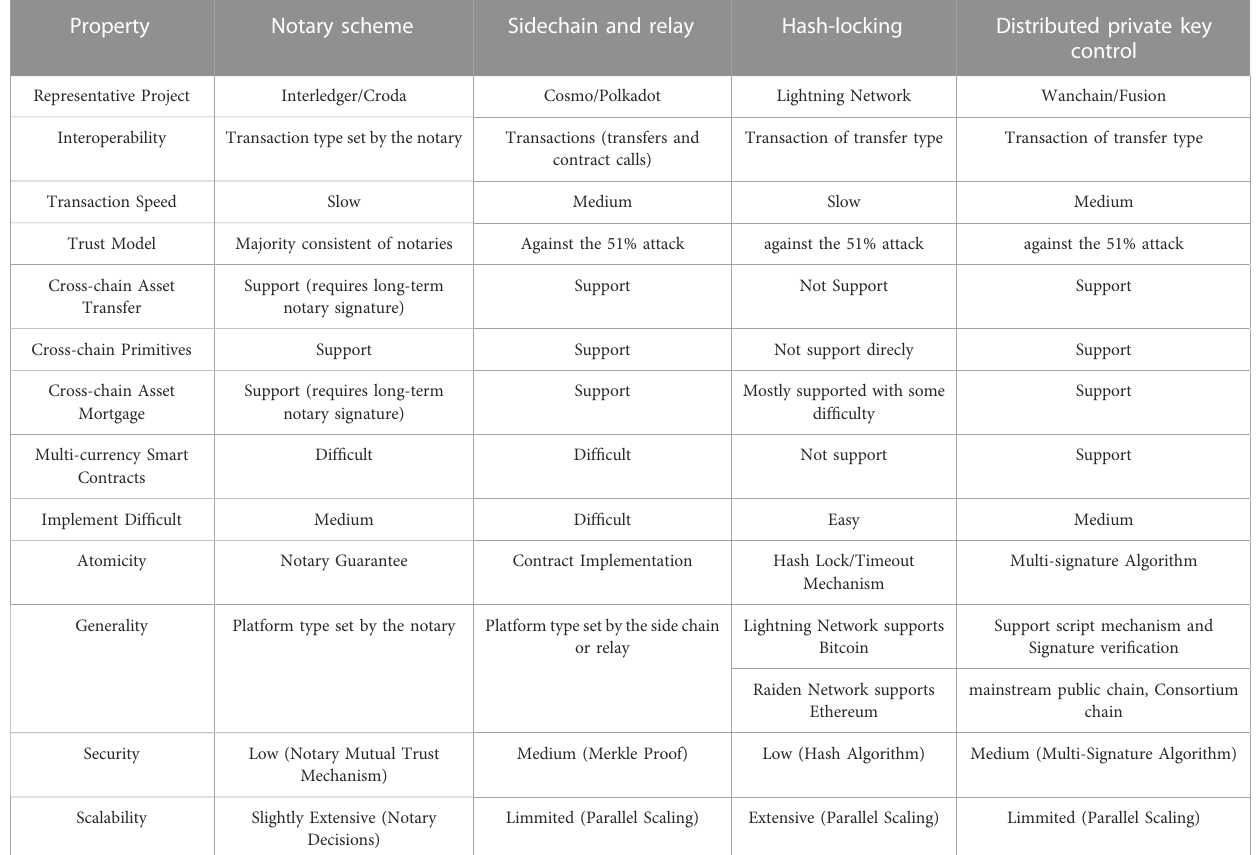
TABLE 1 Comparison of mainstream cross-chain technologies.